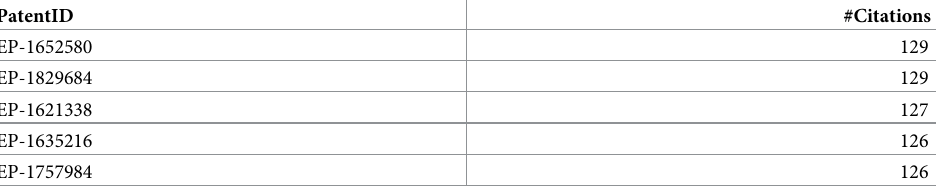
Table 3. Top-5 patents by citation count.